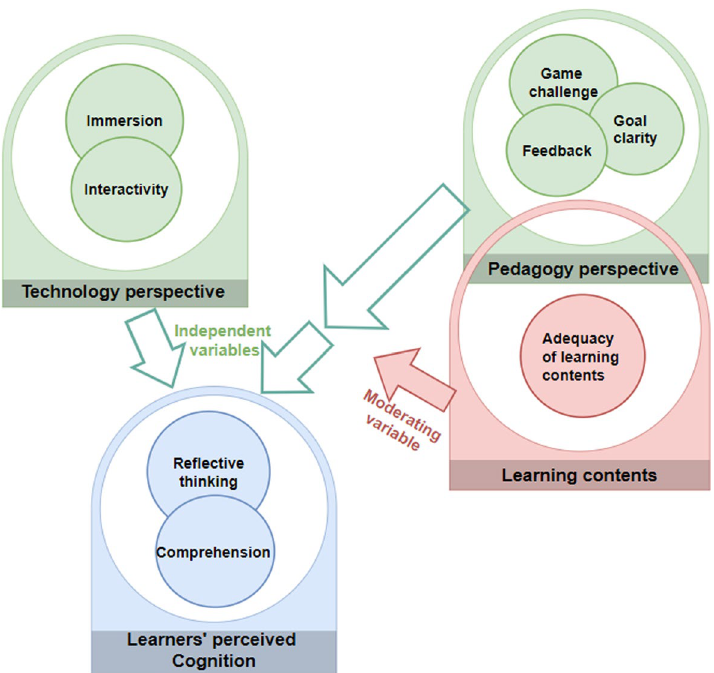
Fig. 1 Conceptual framework of the relationships between IVR, game-based TML, and perceived learners’